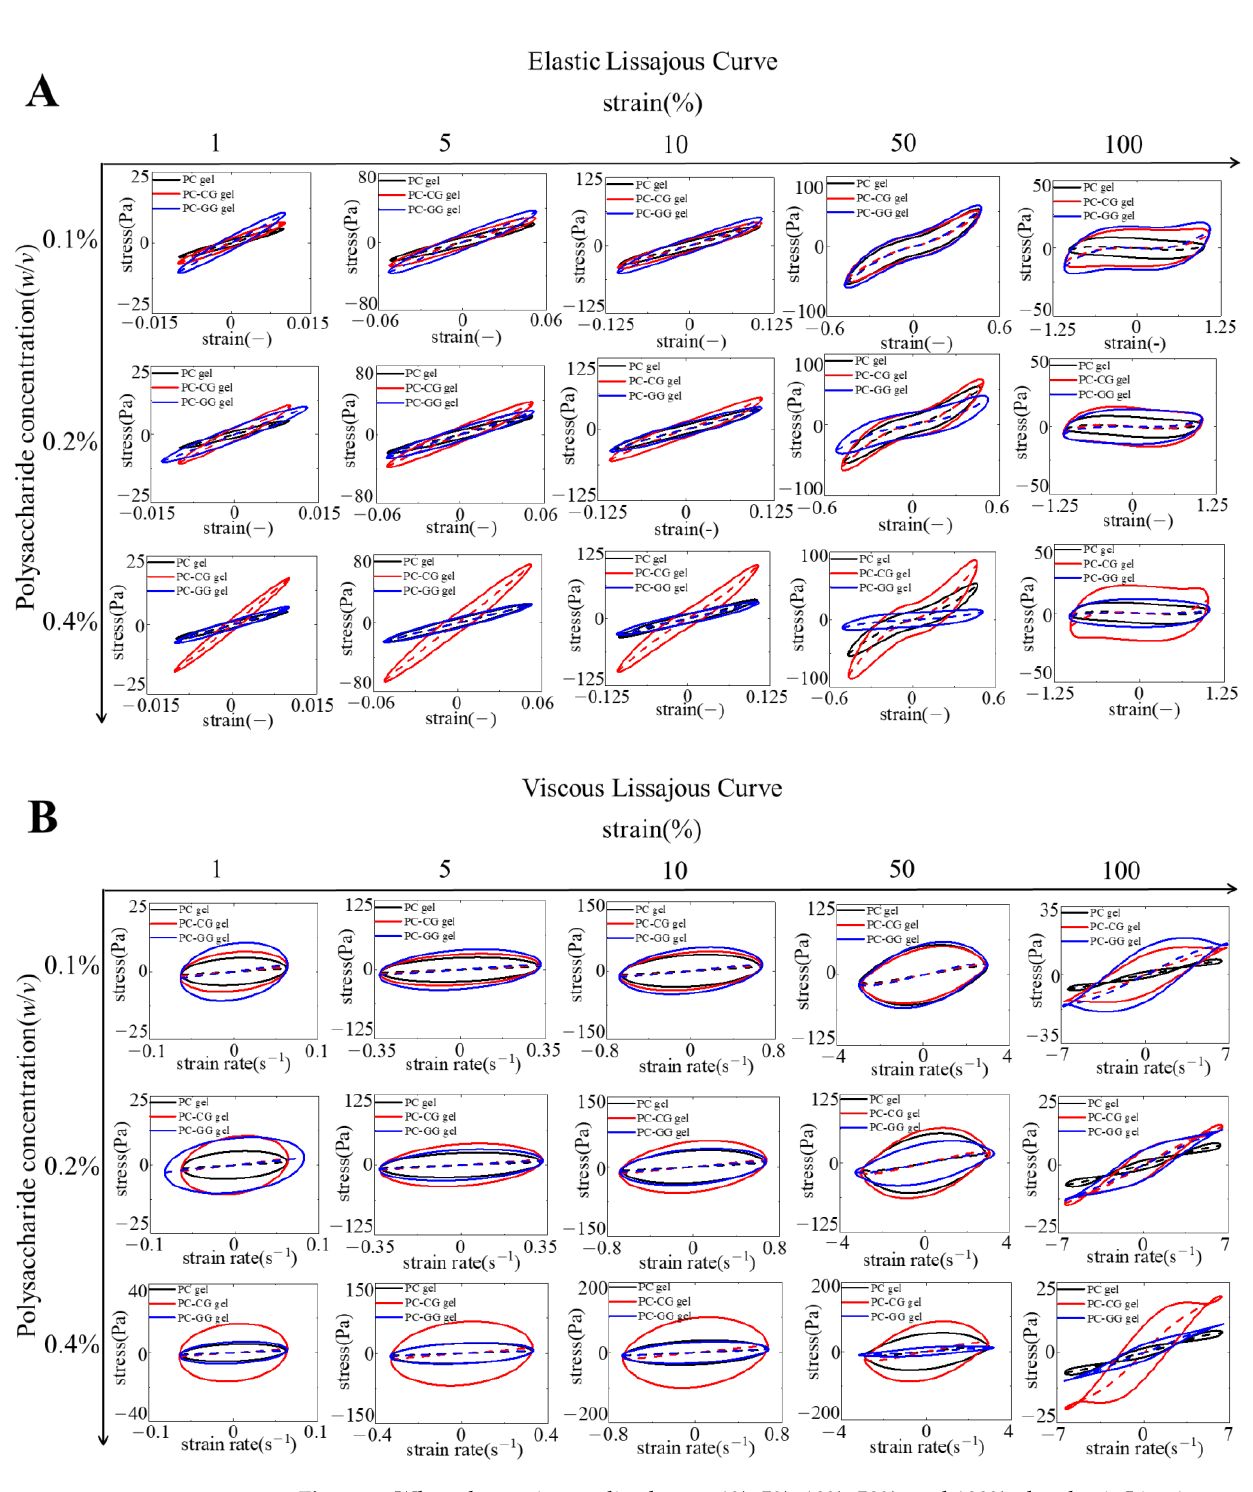
Figure 2. When the strain amplitudes are 1%, 5%, 10%, 50%, and 100%, the elastic Lissajous curve ( A ) and the viscous Lissajous curve ( B ) of 16% PC thermal gels, PC-CG gels, and PC-GG gels, where the black line represents 16% PC thermal gels, the red line represents PC-CG gels, and the blue line represents PC-GG gels. The solid lines represent the total stress, and the dashed lines represent the elastic stress component ( A ) and the viscous stress component ( B ).